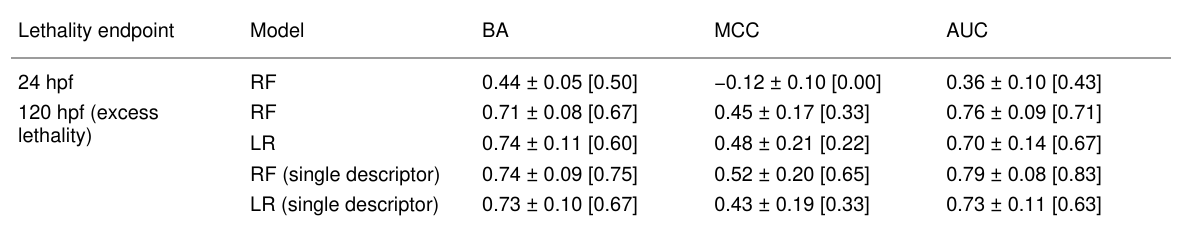
Table 1: Average performance statistics obtained from cross-validation of Random Forest (RF) classification models and logistic regression (LR) models on consistent folds of the model development dataset. All models were built without data augmentation, using all calculated descriptors, unless noted otherwise. All results were obtained via tuning hyperparameters separately for each cross-validation training set, that is, the multiple descriptor results are not expected to suffer from significant optimistic bias. However, the single descriptor (Pauling metal atom electronegativity) models were developed following descriptor importance analysis using the entire model development dataset. The performance in terms of each figure of merit is summarised as the arithmetic mean ± standard error [median]. (The standard error of the mean is an underestimate of the uncer- tainty, as the cross-validation results are not entirely independent.) BA = balanced accuracy, MCC = Matthews correlation coefficient. AUC = area under the receiver operator characteristic (ROC) curve.